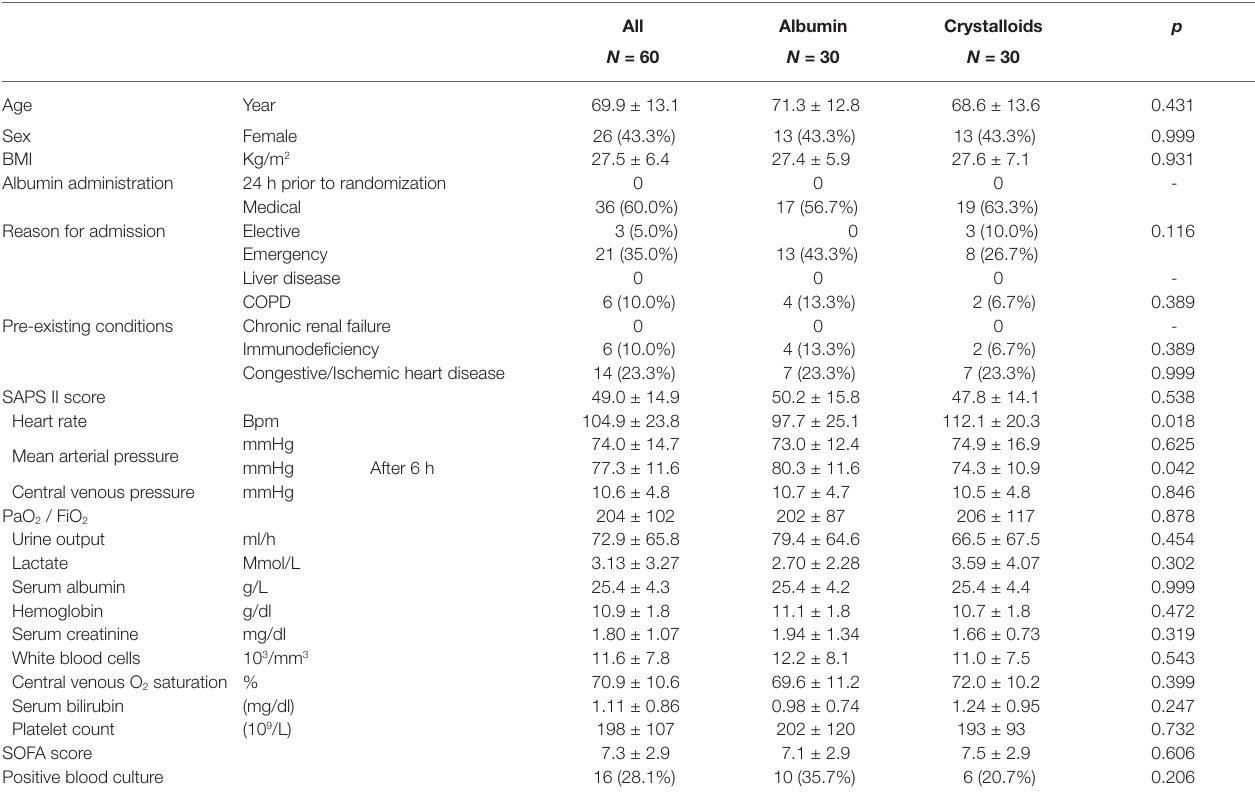
TABLE 1 | Baseline clinical characteristics by randomization